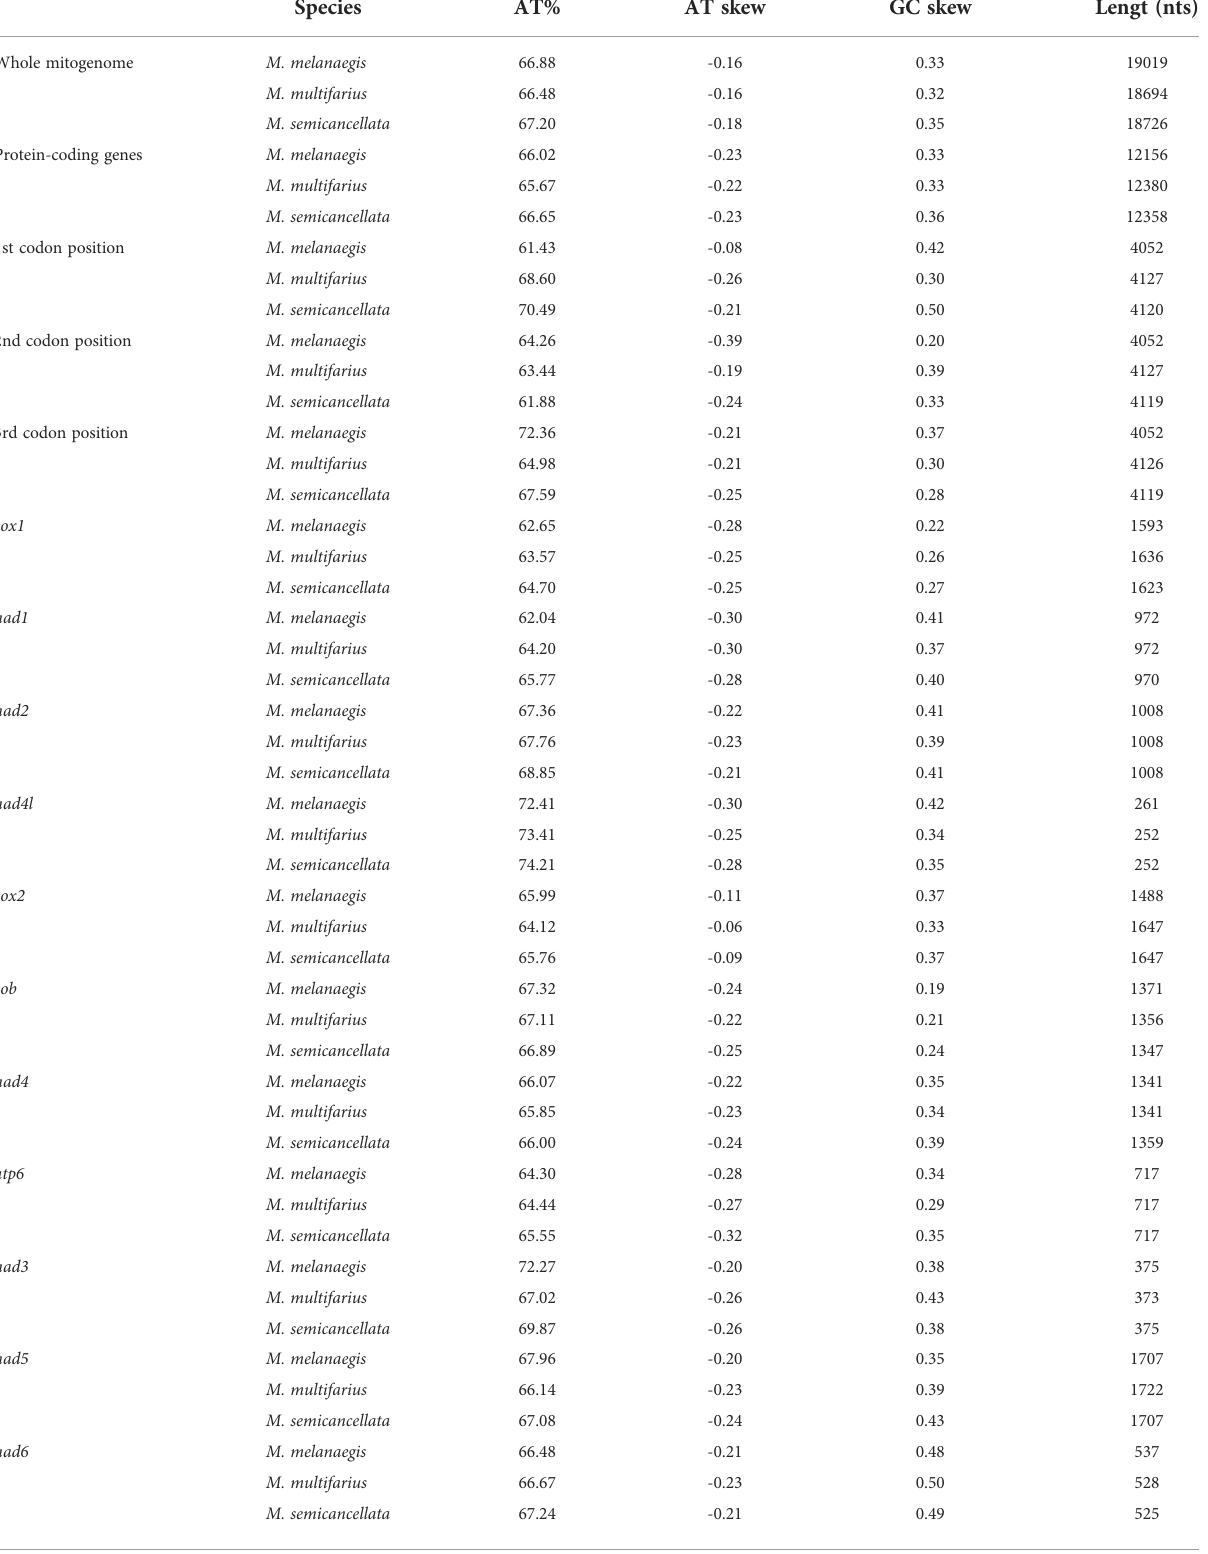
TABLE 2 AT content, AT and GC skew of the M-type mitogenomes of the three Macridiscus species, The order of genes is consistent with mitogenomes. Species AT% AT skew Lengt